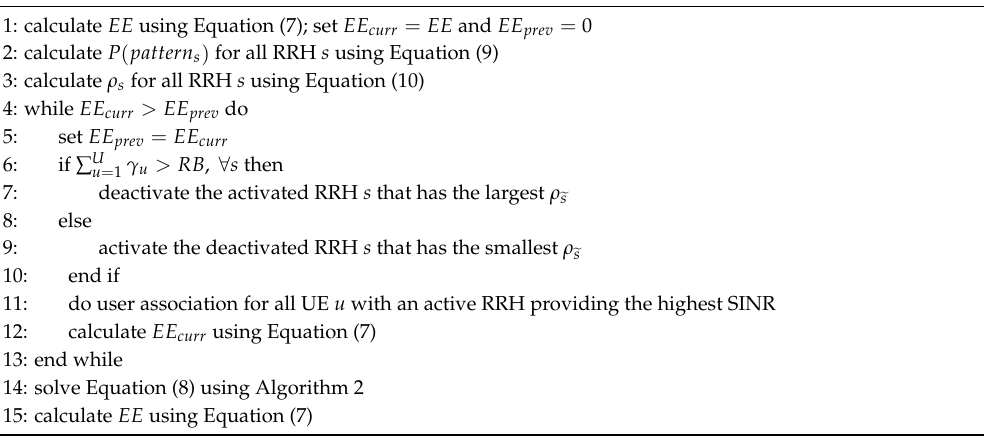
Algorithm 1: RRH switching operation with mobility prediction and SINR-based user